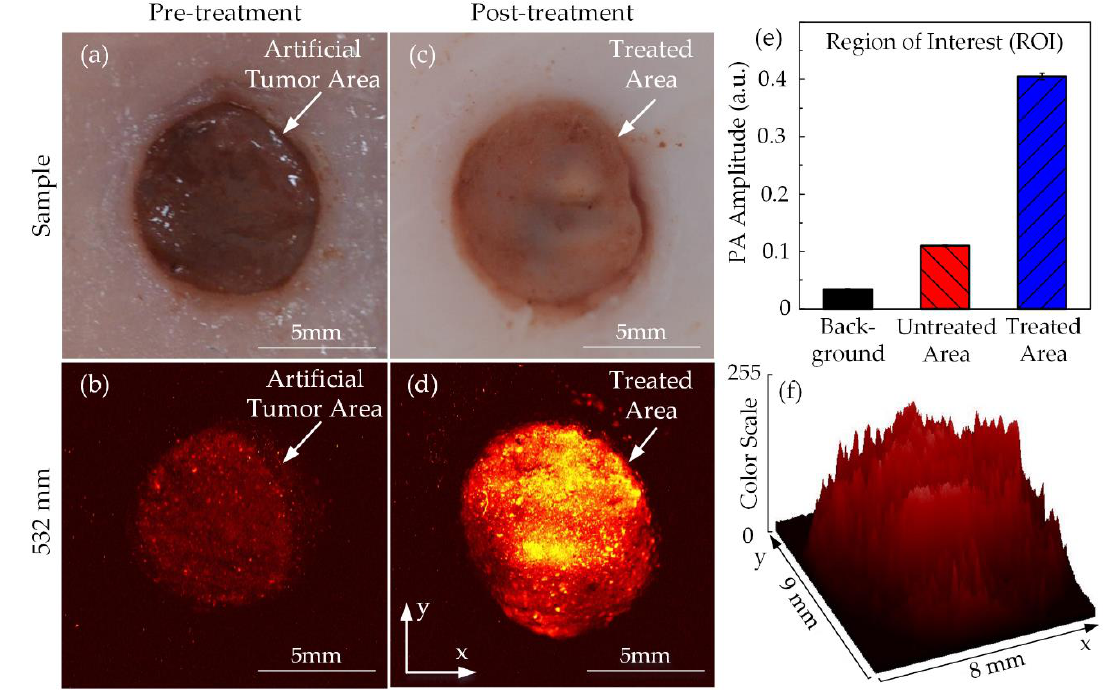
Figure 10. PA images of tumor-injected chicken breast tissue in ex vivo HIFU treatment: tumor images ( a ) Before and ( b ) After treatment PA images ( c ) Before and ( d ) After treatment ( e ) PA amplitude ( f ) 3D image of the treated area according to the color scale.